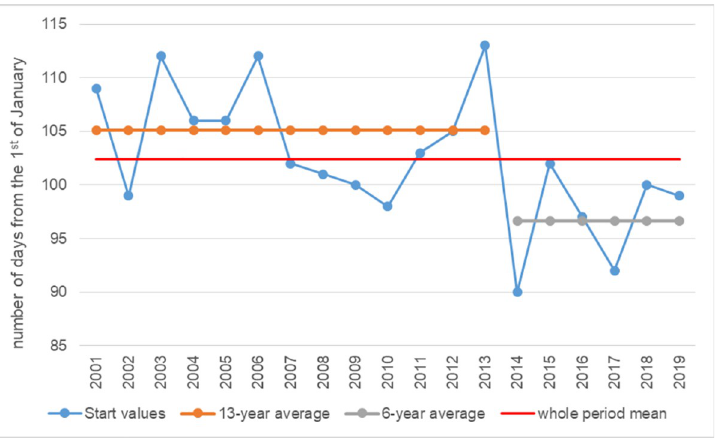
Fig 3. Onset means for sub-periods significantly different from the overall average at a 0.01 significance level.